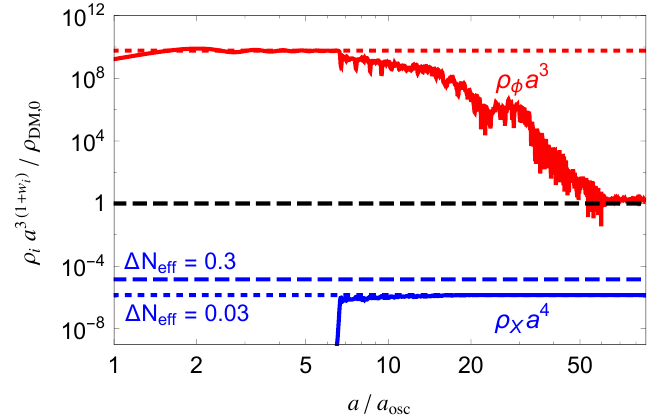
Figure 4 . Comoving energy densities normalized to the present time dark matter energy density, for the ALP 2 benchmark model. Here, the scale factor is normalized to unity at the present time. orders of magnitude, signi(cid:12)cantly widening the range of axion masses and decay constants that are consistent with cosmology [11]. As an example, the red curve in (cid:12)gure 4